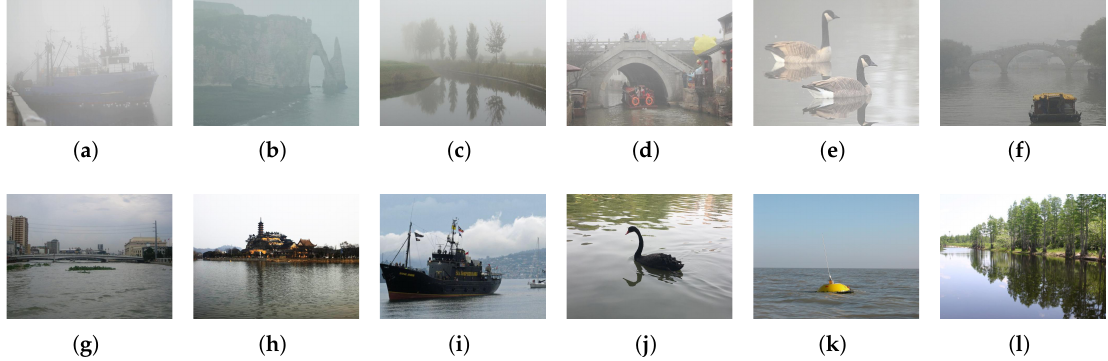
Figure 6. Examples of HazyWater dataset (best viewed in color). ( a – f ) Hazy images. ( g – l ) Clean